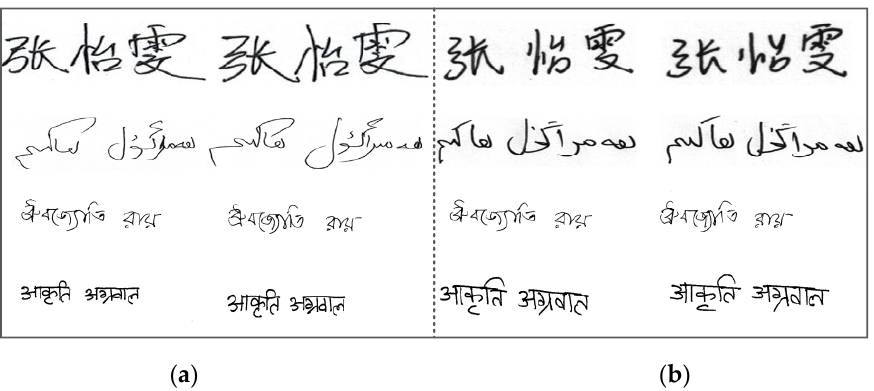
Figure 2. Some multi-language offline handwritten signatures: ( a ) an example of partial genuine signatures in Chinese, Uyghur, Bengali, and Indian languages; ( b ) an example of partial forged signatures in Chinese, Uyghur, Bengali, and Indian languages. (Example of Chinese signature in the figure: Zhang Yiwen)